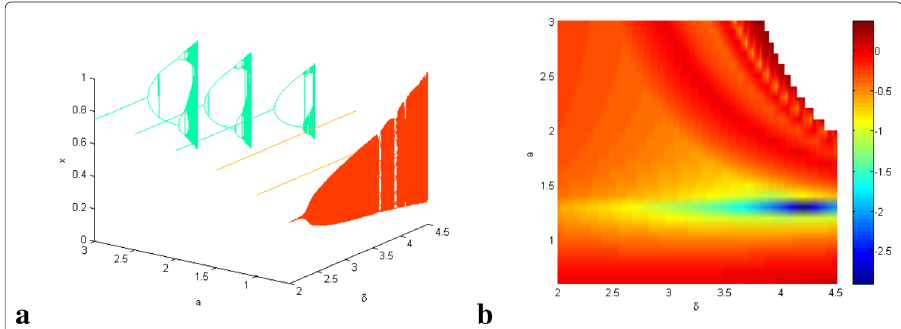
Fig. 5 Bifurcation diagram in (δ − a − x ) space. ( a ) the transition between NS bifurcation and flip bifurcation for prey when δ ∈ [2.0,4.5], a = 0.6,1.0,1.5,2.0,2.5,3.0 ∈ [0.6,3.0]. b The 2D projection of 3D